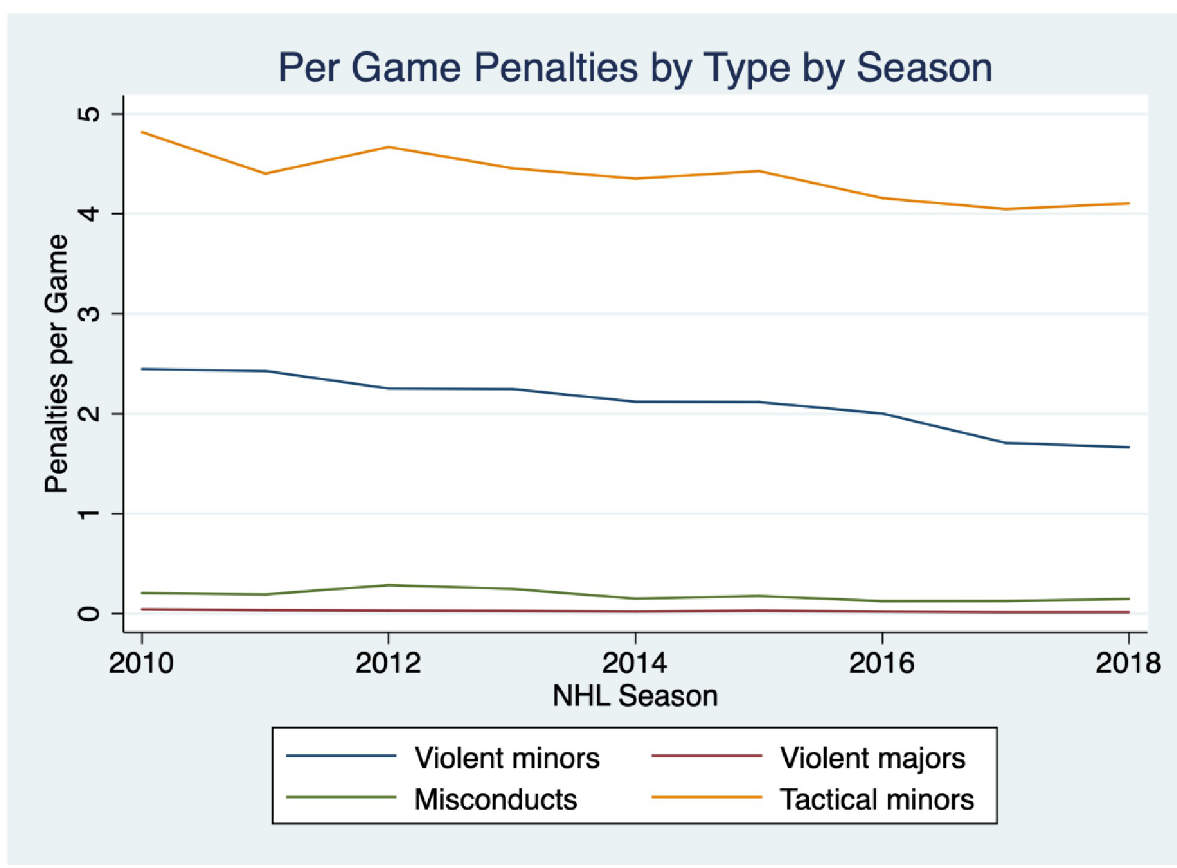
Fig 2. Per game penalties by type by season 2010–2019. Fig 2 shows the average number of penalties per game by season for each of tactical, violent minor, violent major, and misconduct penalties between the 2010–11 and 2018–19